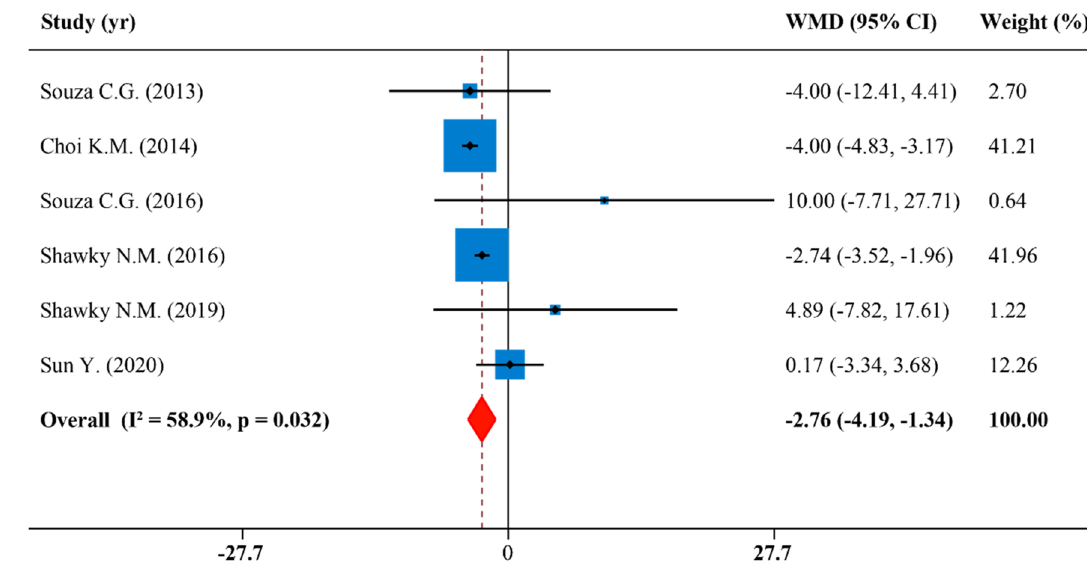
Figure 2. Forest plot showing effects of SFN on body